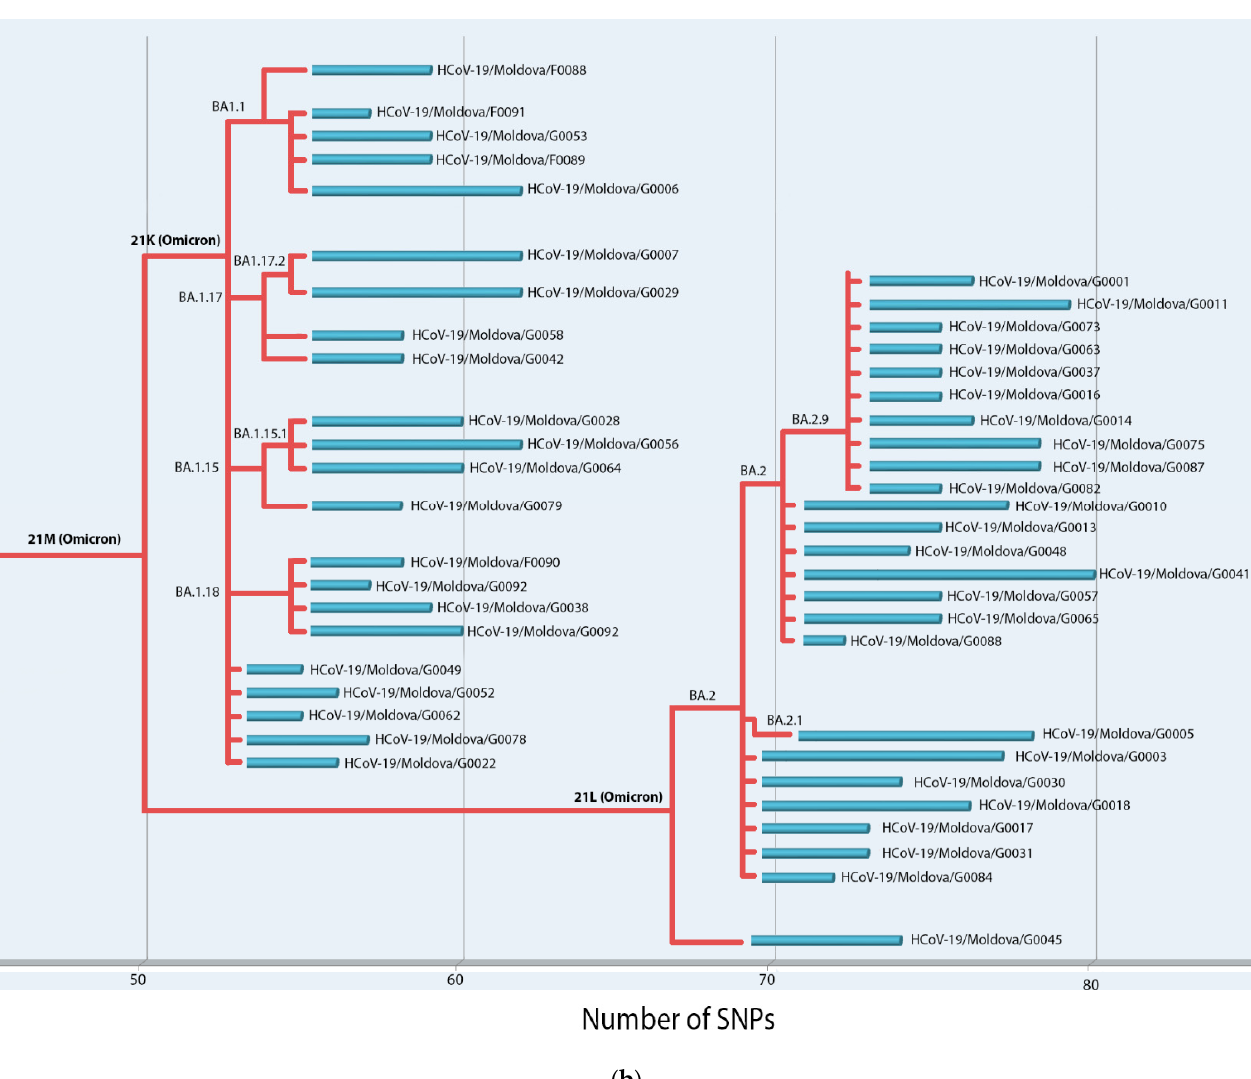
Figure 1. ( a ) Number of the SNPs and classification of the Delta variant of SARS-CoV-2 isolates from Moldova according to the Nextclade Pango Lineage nomenclature compared to the Wuhan complete genome sequence. ( b ) Number of SNPs and classification of the Omicron variant of SARS-CoV-2 isolates from Moldova according to the Nextclade Pango Lineage nomenclature compared to the Wuhan complete genome sequence.